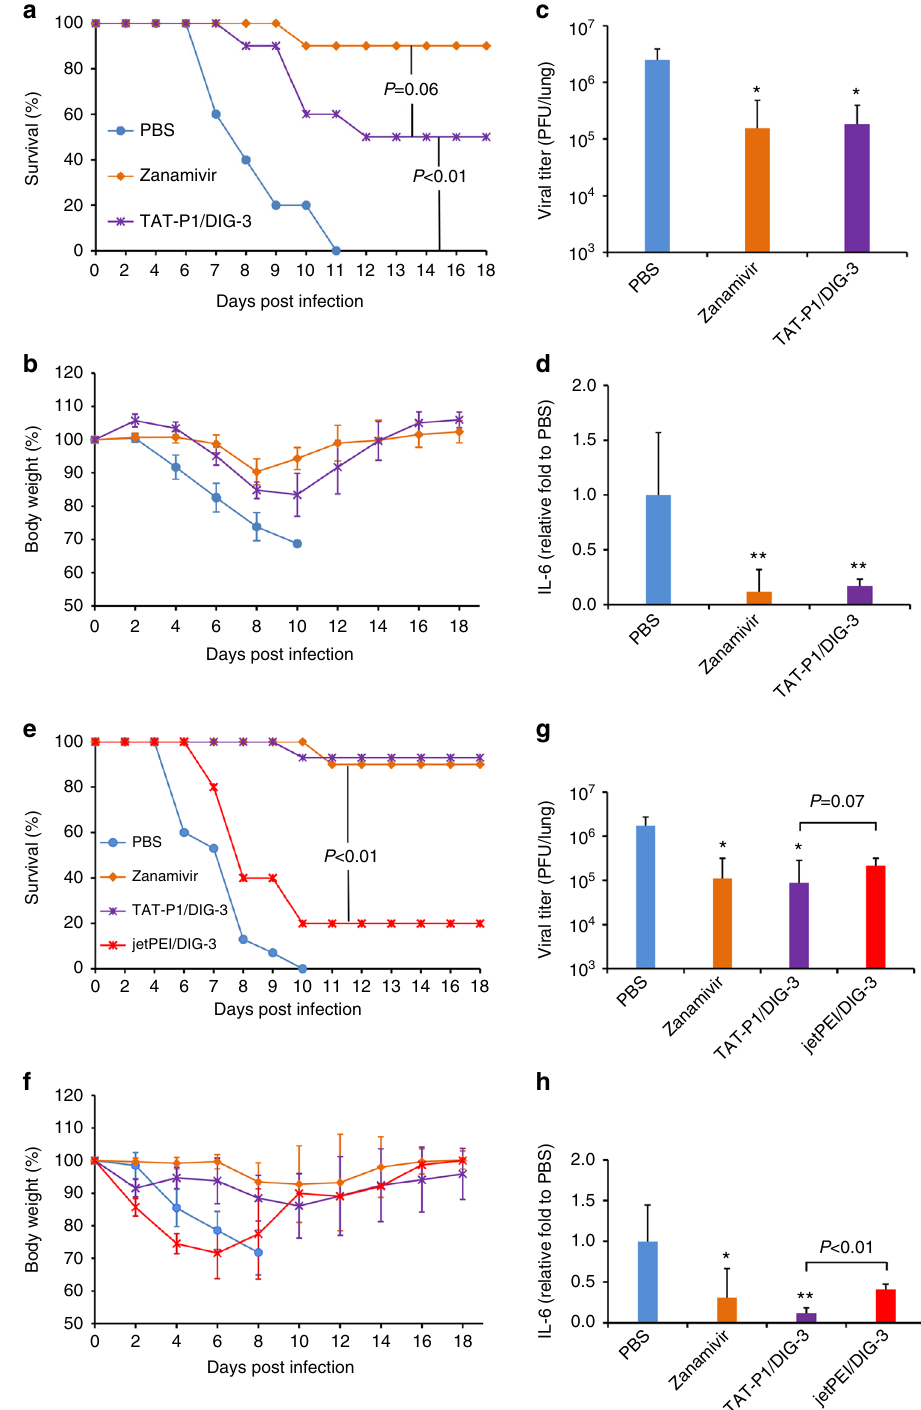
Fig. 6 TAT-P1/DIG-3 could provide prophylactic and therapeutic protection against A(H1N1)pdm09 virus infection in mice. a – d Prophylactic ef fi cacy of TAT-P1/DIG-3 against A(H1N1)pdm09 virus. e – h Therapeutic ef fi cacy of TAT-P1/DIG-3 against A(H1N1)pdm09 virus. For prevention, 40 μ l of PBS ( n = 10), zanamivir (50 μ g in PBS, n = 10), and TAT-P1/DIG-3 (20 μ g/5 μ g in distilled water, n = 10) were intratracheally inoculated to corresponding mice at 48 and 24 h before viral inoculation. For therapeutic experiment, PBS ( n = 15), zanamivir (10), TAT-P1/DIG-3 ( n = 15) or jetPEI/DIG-3 (20 μ g/5 μ g in 5% glucose solution, n = 5) were intratracheally inoculated to corresponding mice at 6 h and 24 h after viral inoculation. Viral titers and IL-6 in mouse lungs were detected at day 4 post infection with mean ± SD of >3 mice in each group. The expression of IL-6 was normalized to PBS group. * Indicates P < 0.05. ** Indicates P < 0.01 when compared with PBS group. P values were calculated by Gehan – Breslow – Wilcoxon test for survivals and by the two- tailed Student ’ s t test for viral titer and IL-6